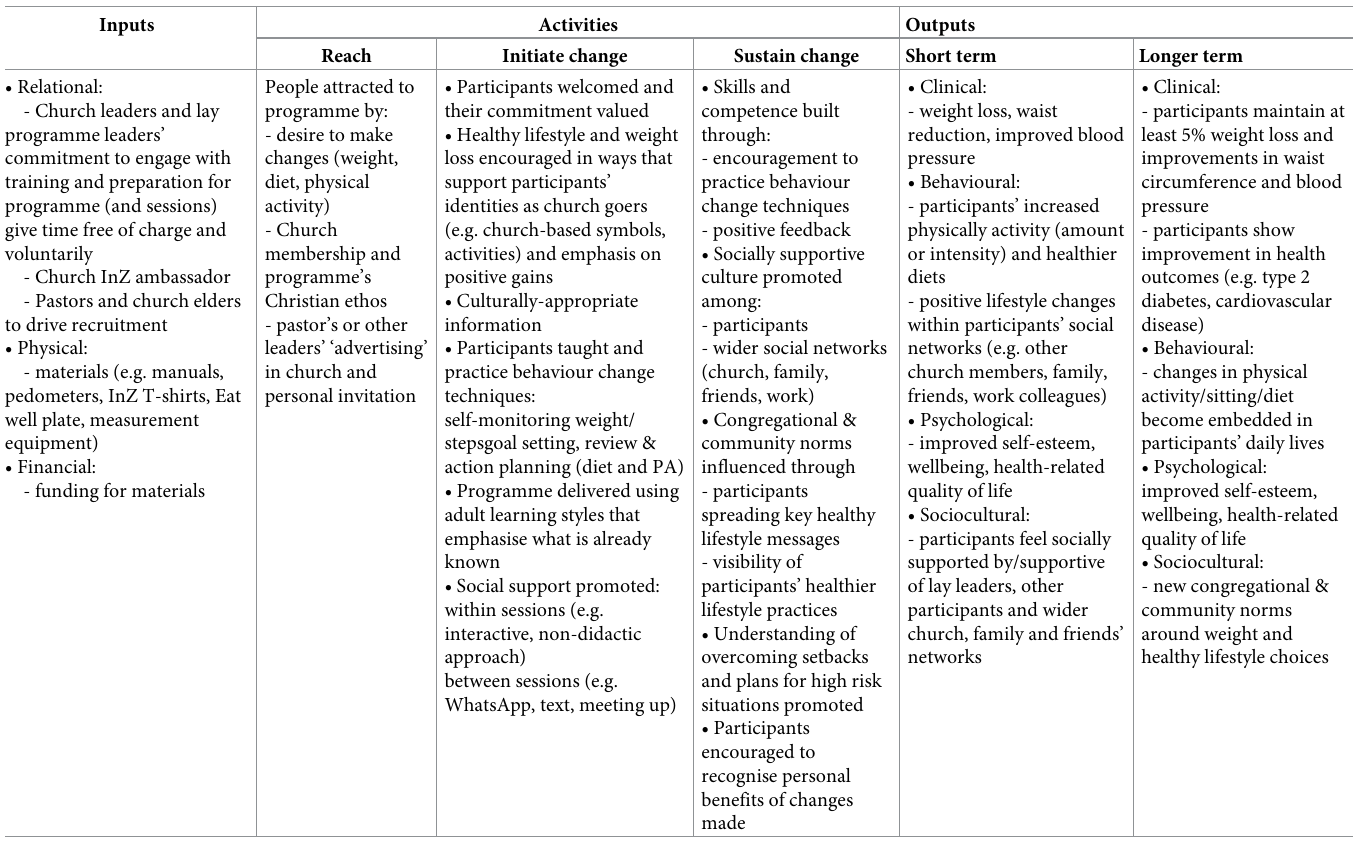
Table 3. Impilo neZenkolo (InZ) Logic